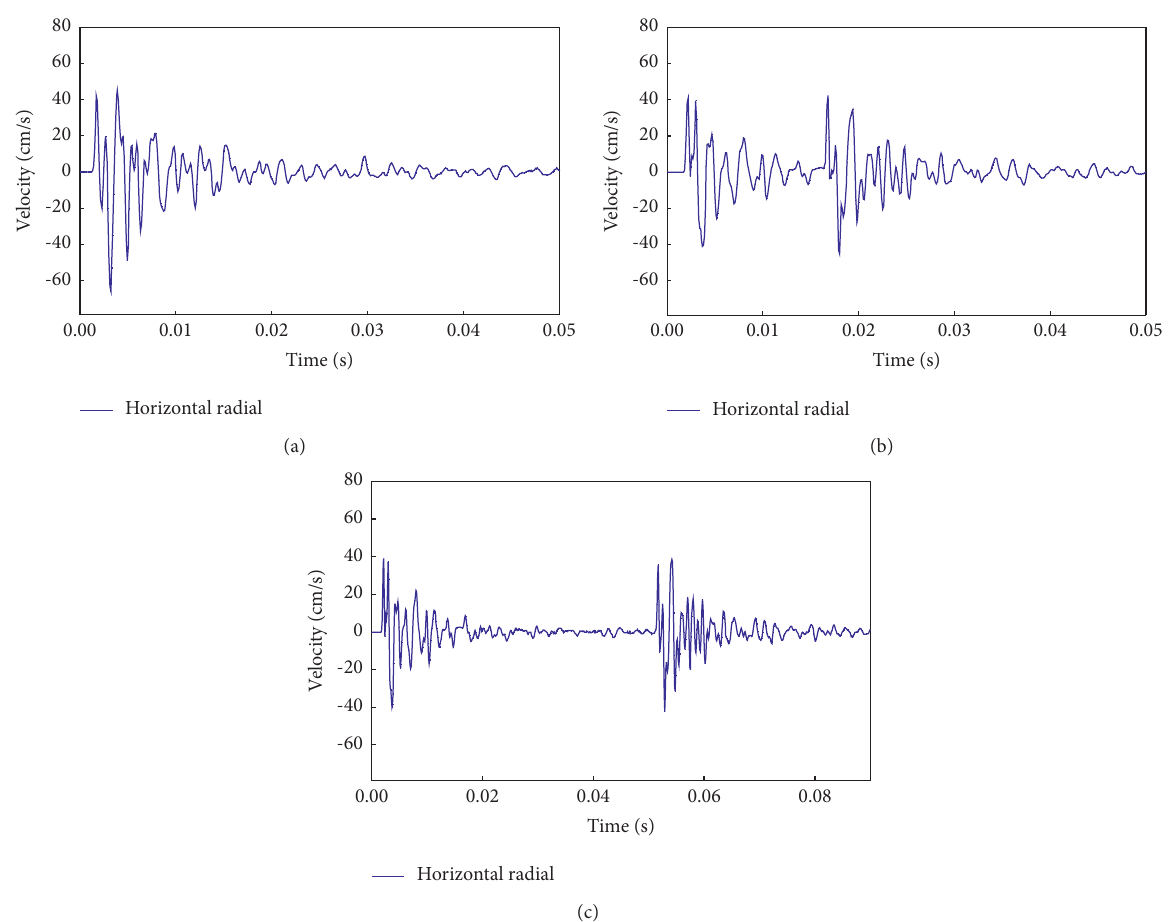
Figure 13: Vibration waveform of blasting models with different delay times. (a) Δ ( t ) � 0ms. (b) Δ ( t ) � 15ms. (c) Δ ( t ) � 50ms.